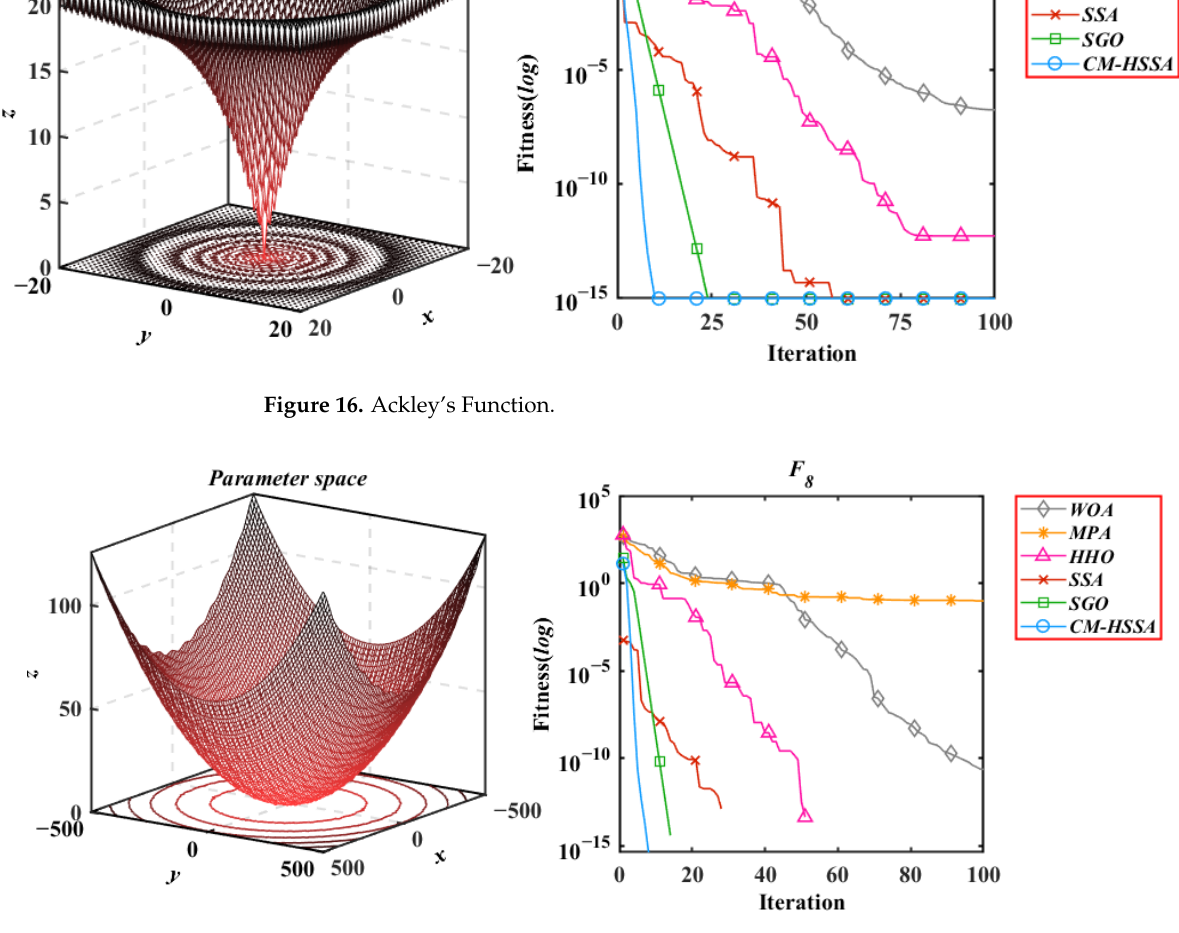
Figure 17. Generalized Griewank Function.